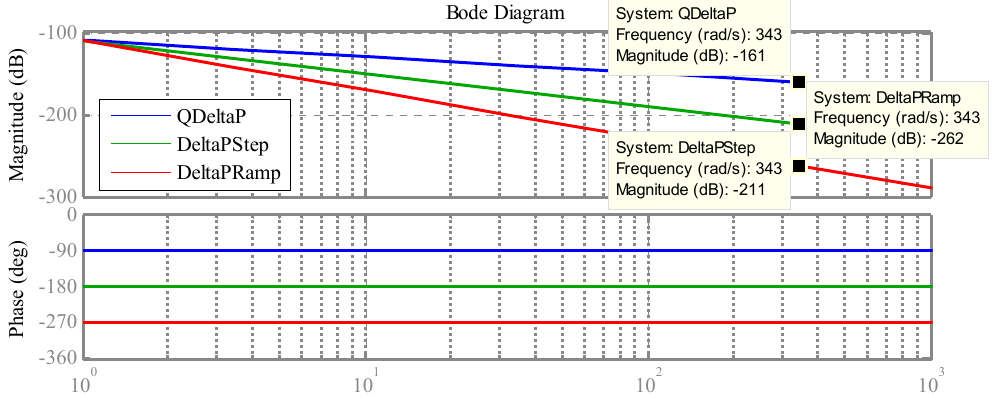
Figure 5. Bode diagrams for Q / ∆ P as well as the step and ramp changes of active power error.